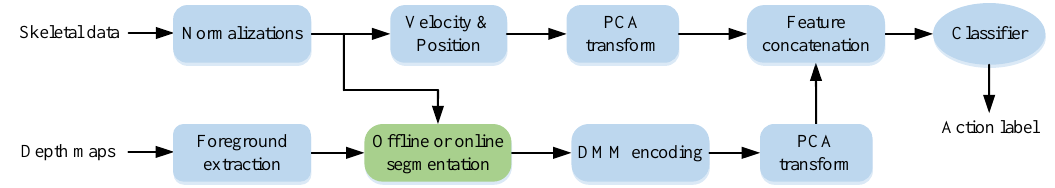
Figure 3. Training and test processes of the developed depth motion map-based methods. The difference between the training and the test processes lie in the sequence segmentation step that is marked in green.